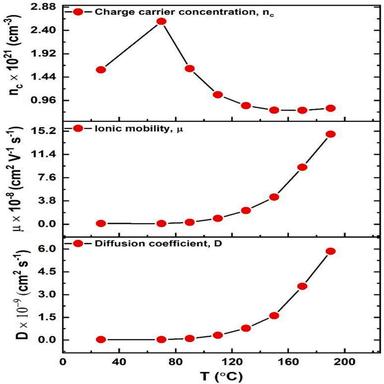
The variation of concentration of charge carriers (nc), ionic mobility (μ) and diffusion coefficient (D) at all temperatures.